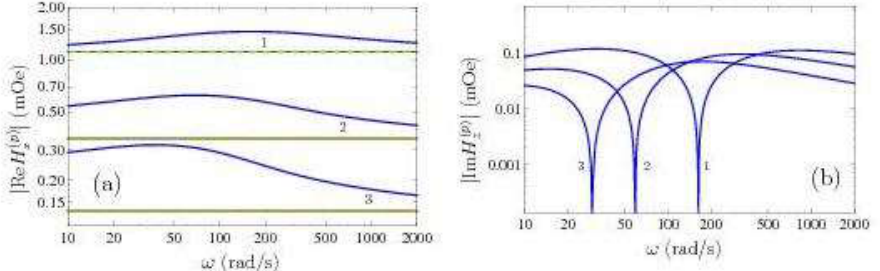
Figure 7. The magnitudes of real part ( a ) and the imaginary part ( b ) of the normal component of monochromatic magnetic field in the domain above the copper plate computed using the Drude model at the dipole height of 1 cm are shown by the solid lines labeled 1, 2, and 3 as the functions of oscillation frequency at separations from the magnetic dipole equal to 30, 40, and 50 mm, respectively. The three solid lines labeled 1, 2, and 3 overlapping with the dashed ones ( a ) are computed using the plasma and spatially nonlocal models at separations of 30, 40, and 50 nm,